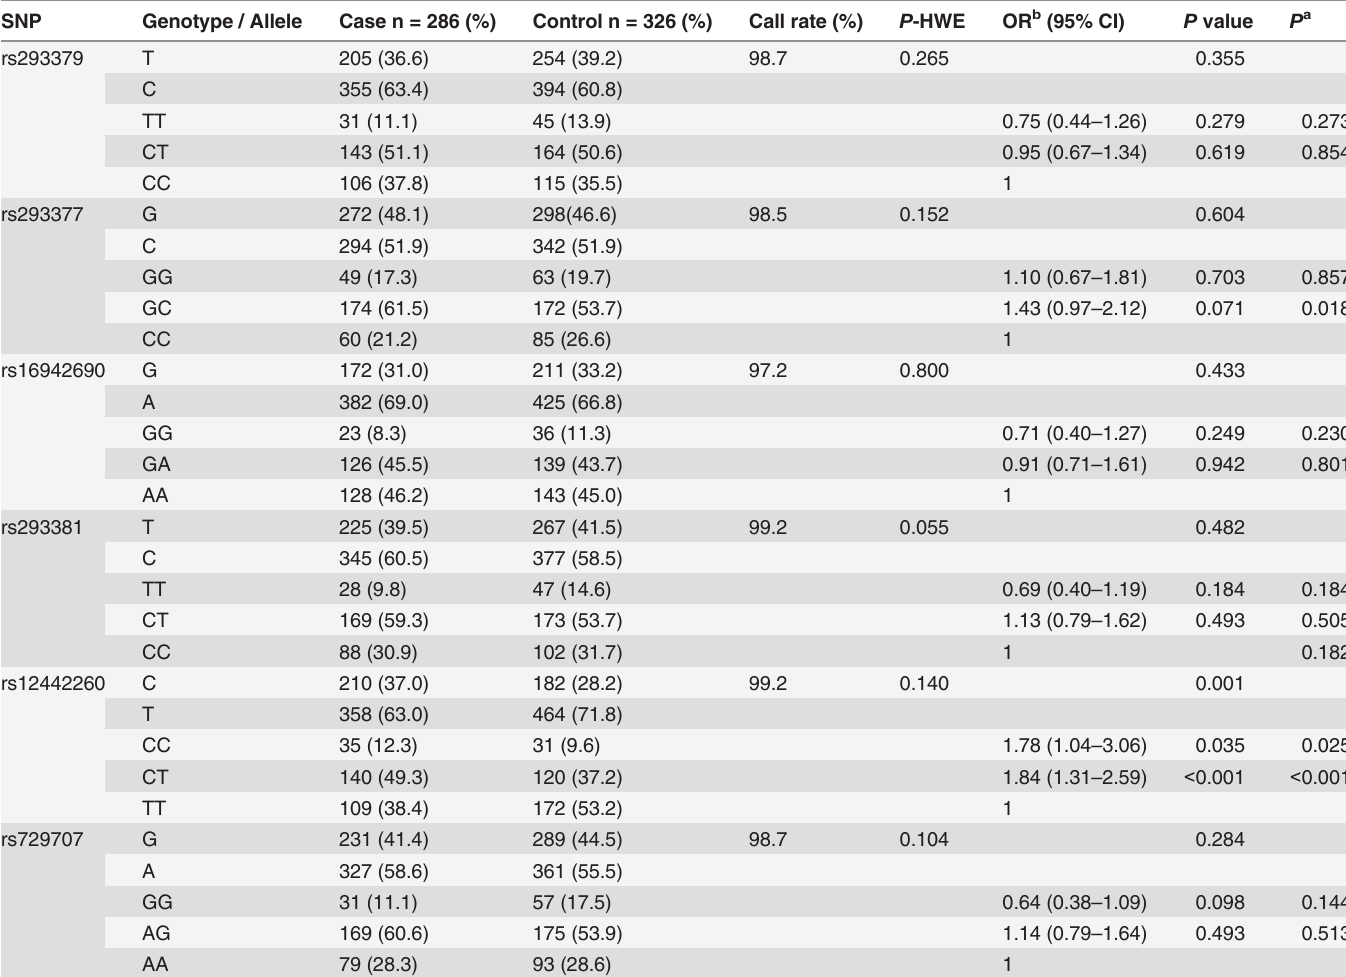
Table 2. Risk associated with the six